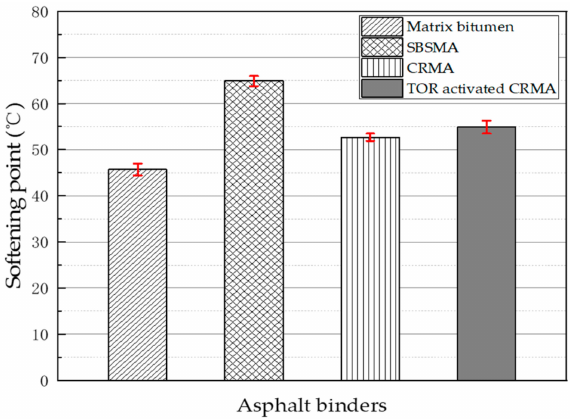
Figure 3. Softening point of four binders on unaged asphalts.